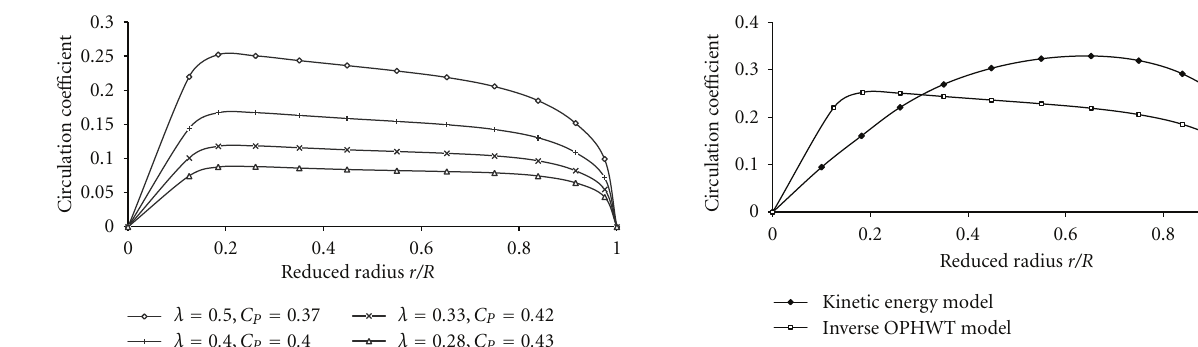
Figure 2: Circulation Coe ffi cient on the lifting line for N b = 3 for the inverse OPHWT model.